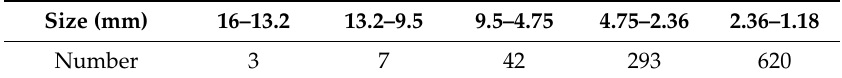
Figure 8. The DEM of the virtual track test. Table 10. Number of coarse aggregate clumps.